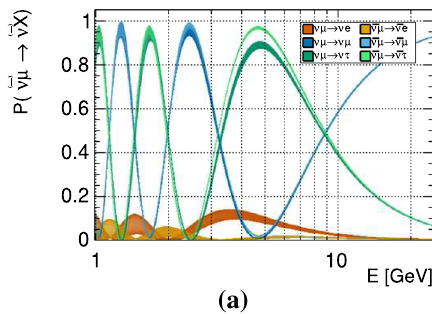
The probabilities for different δ CP values are shown with different line styles. In both a and b , the oscillation baseline is 2595 km. The oscilla-